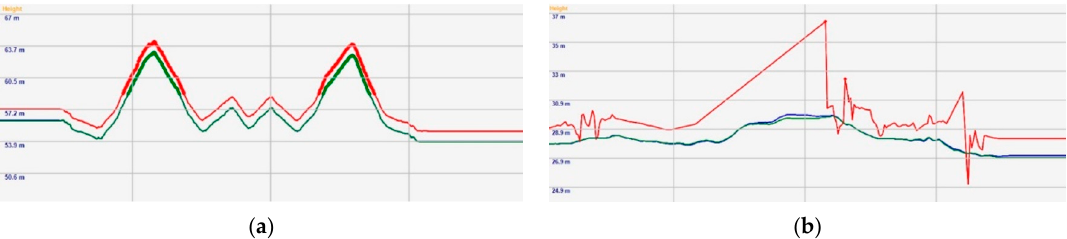
Figure 6. ( a ) Altitude result in open area; ( b ) Altitude result in urban area. Red: Pure GNSS, Blue: GNSS with IMU and VBS-RTK after post processing, Green: GNSS with IMU, VBS-RTK and Car speed information after post-processing.